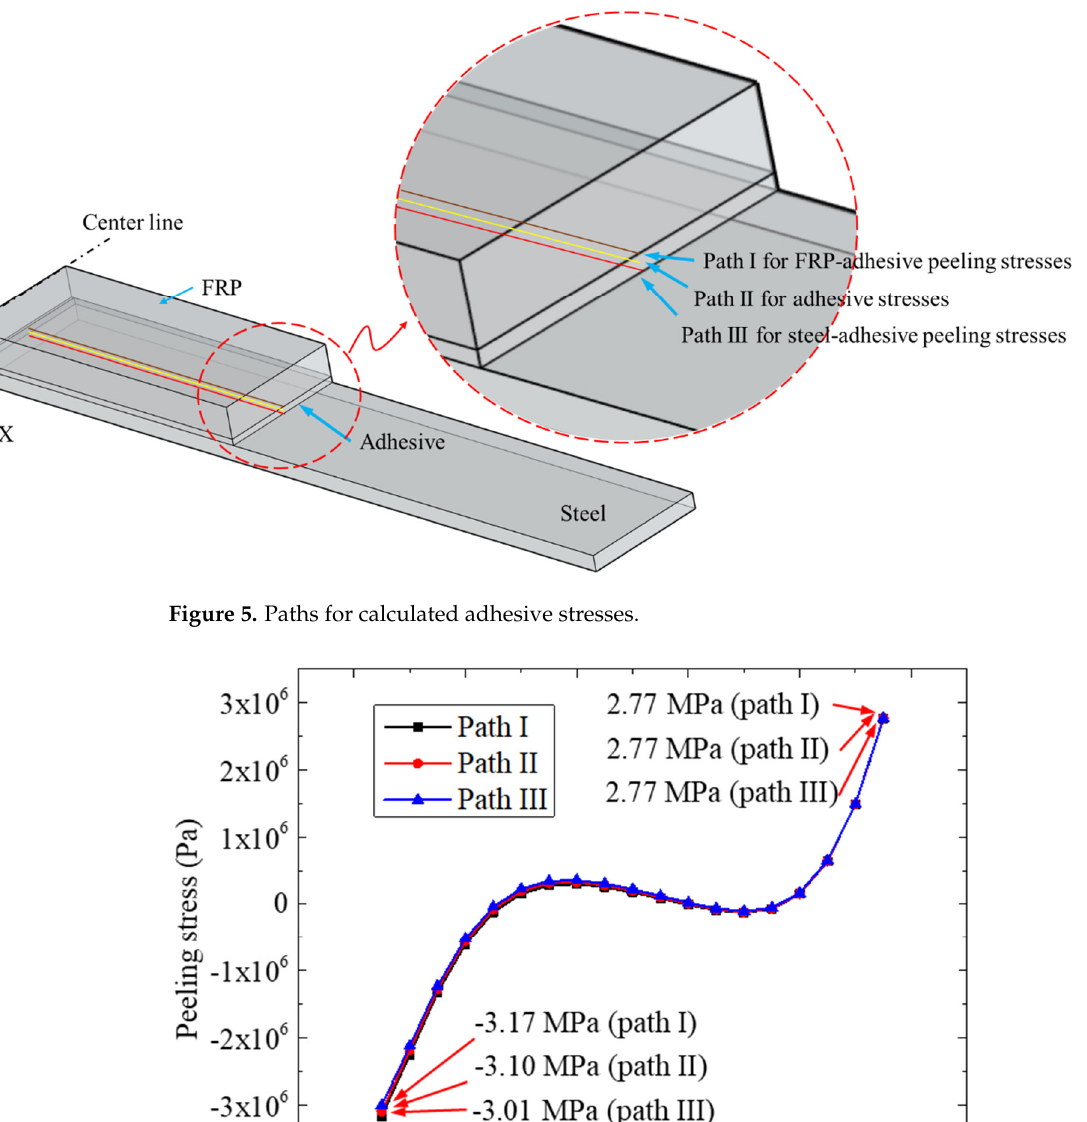
Figure 5. Paths for calculated adhesive stresses.